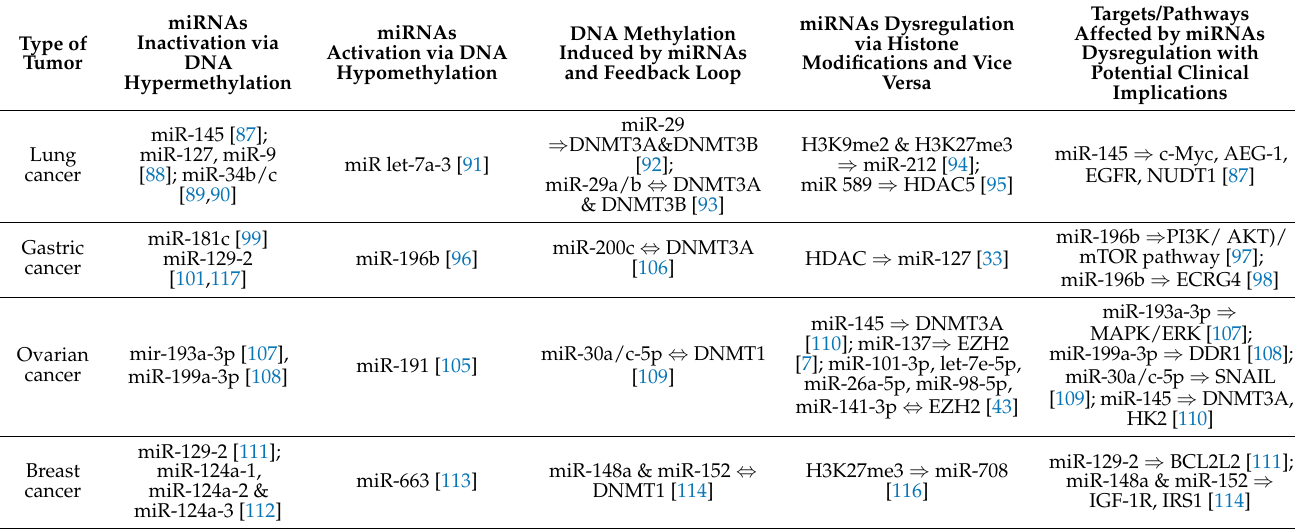
Table 1. Epigenetic bidirectional regulation between epigenetic mechanisms and miRNAs disrupted in some types of cancer diseases, with biological